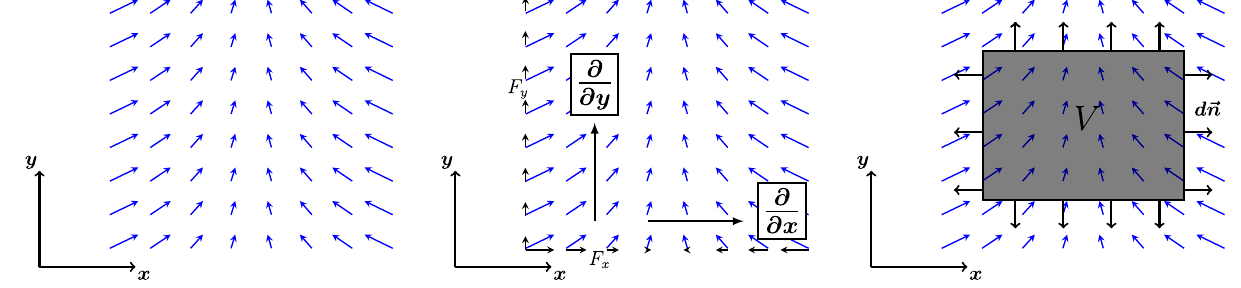
FIG. 1. Graphical representation of a two-dimensional vector field (left). Divergence of this field is constant and negative, as we can prove qualitatively. Using the differential strategy (DS), we conclude that F x becomes smaller in the x direction and F y is constant (center). Using the integral strategy (IS), we observe a negative net flux through the left and right boundaries of a test volume, while there is no net flux through the upper and lower boundaries (right). Both arguments hold for every position in the field and for any test volume